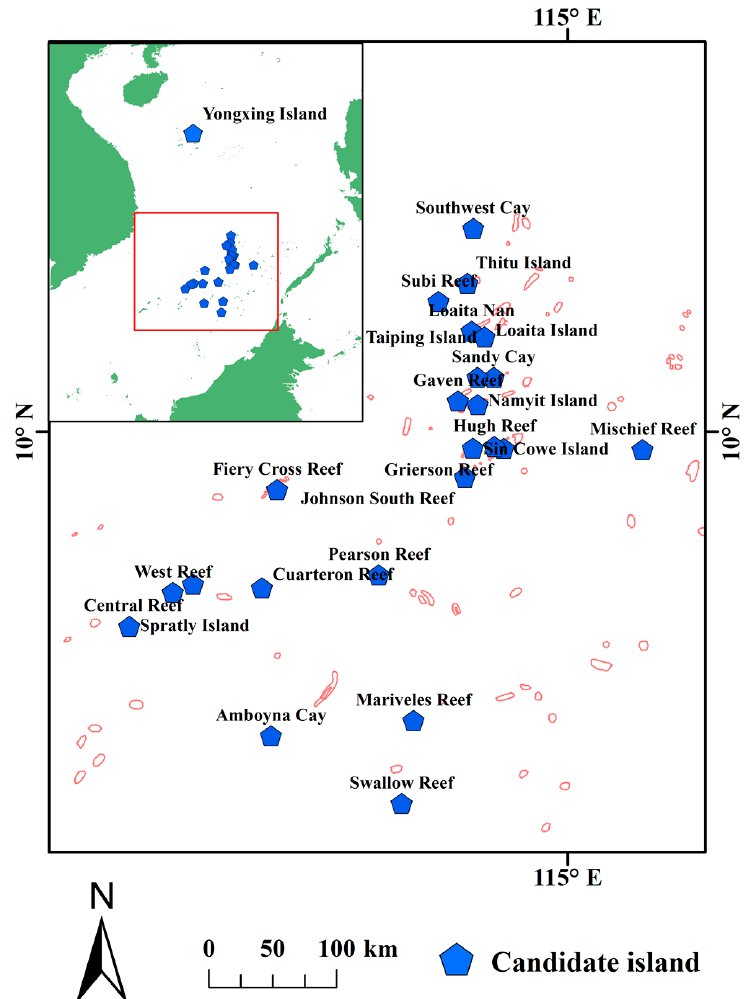
Figure 6. The locations of candidate islands in the South China Sea.